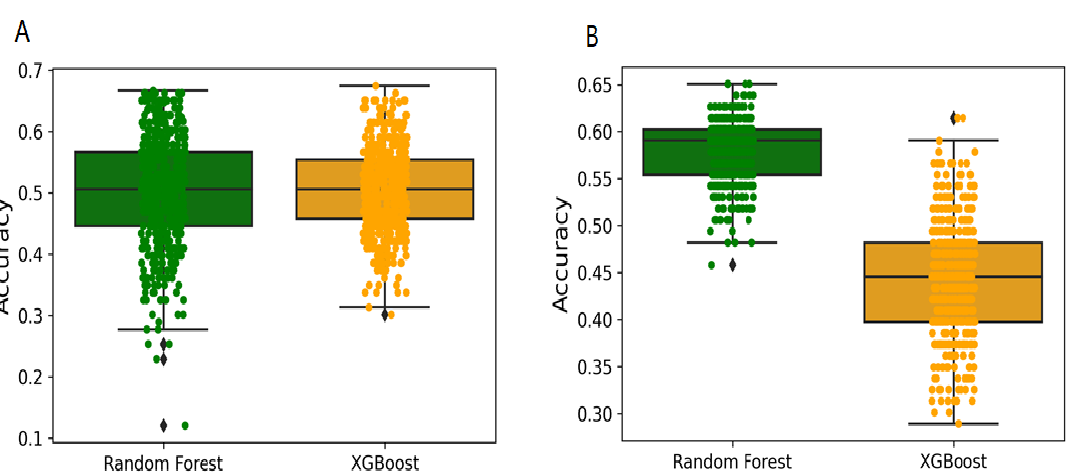
Figure 5. Box plot showing the frequencies of accuracies from Y-randomization models. ( A ) Binary class models. ( B ) Multi- class models. Total 500 Y-randomization runs were performed.